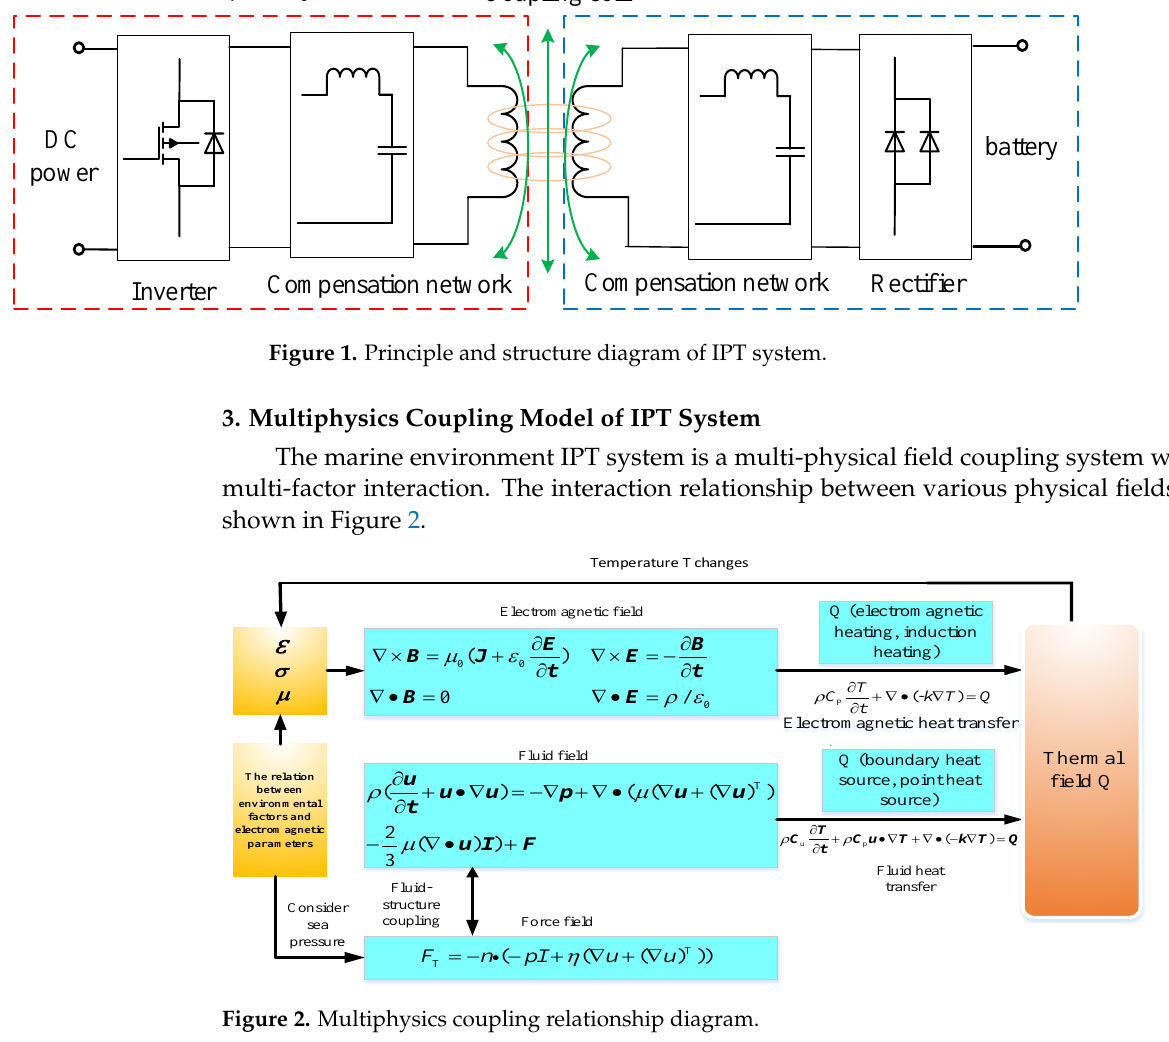
Figure 2. Multiphysics coupling relationship diagram .